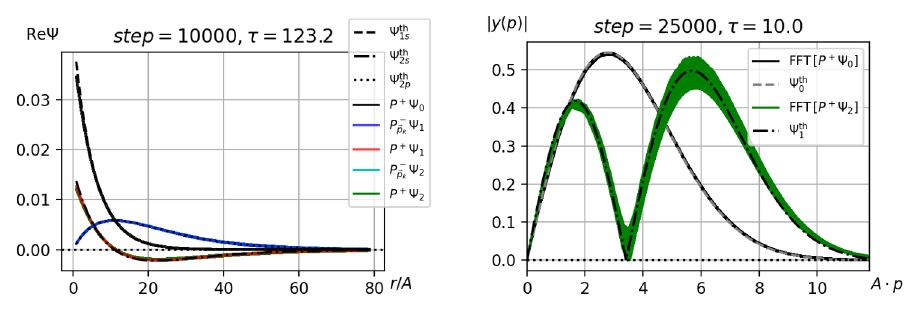
and H (2) at τ = 123 . 2 (non-relativistic kinetic K K solver is almost indistinguishable from the H (2) one (see K K